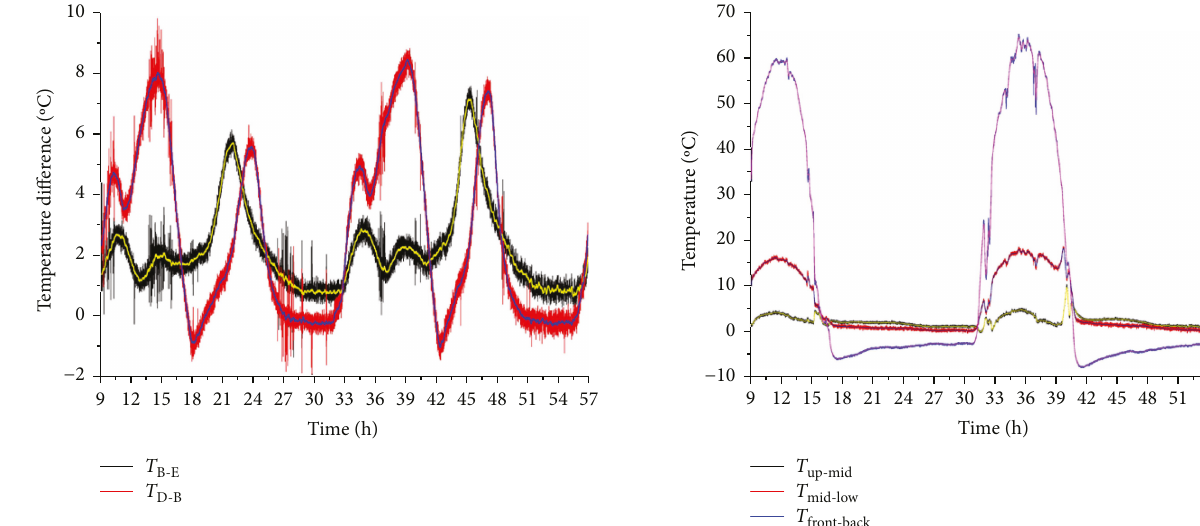
Figure 9: Comparison of the interior side temperature di ff erence between the upper, middle, and lower PCM boards. Figure 10: Temperature di ff erence between the upper, middle, and